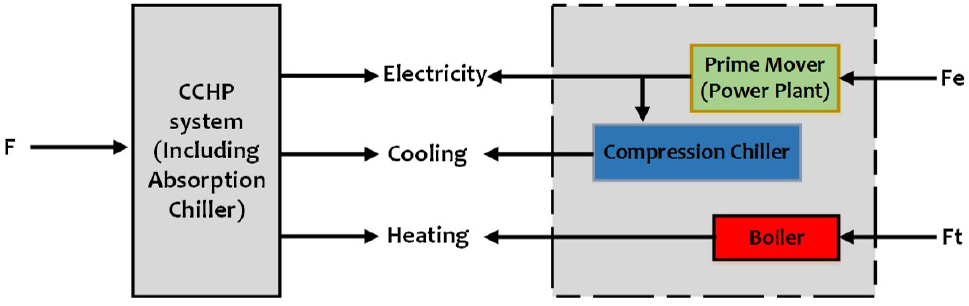
Figure 2. Comparison of conventional and CCHP power systems